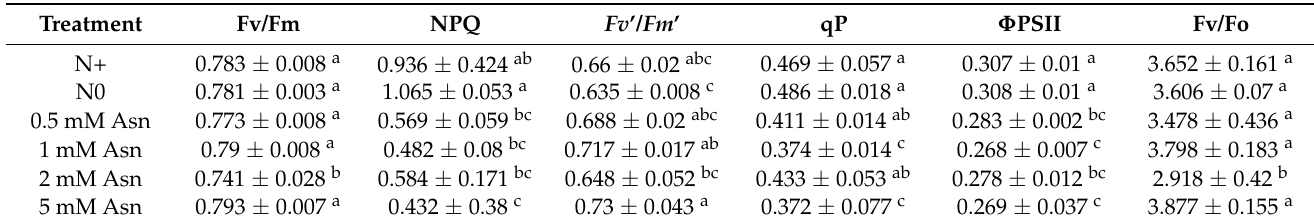
Table 3. Chlorophyll fluorescence parameters of the poplar ‘Nanlin895’ under different asparagine (Asn) treatments.